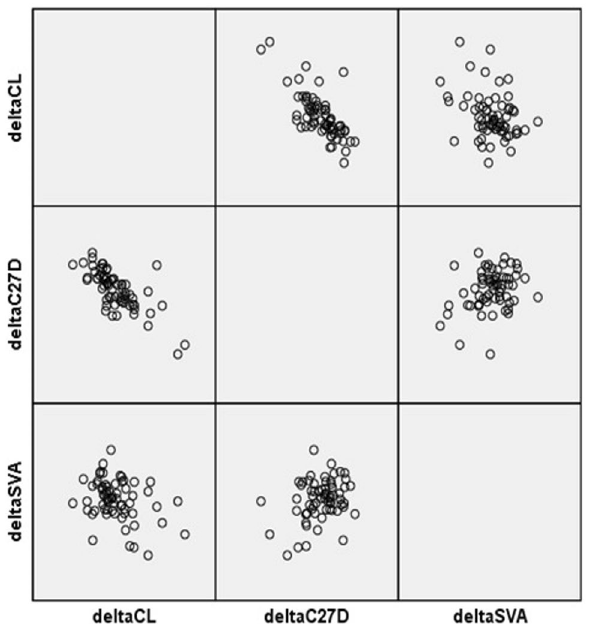
Figure 3. Scatterplot matrix of ΔCL, ΔC27D, and ΔC27SVA. A significantly negative correlation was found between ΔCL and both ΔC27D and ΔC27SVA. Δ (delta), postoperative–preoperative value; CL, cervical lordosis; C27D, C2–7 interspinous process distance; C27SVA, C2–7 sagittal vertical